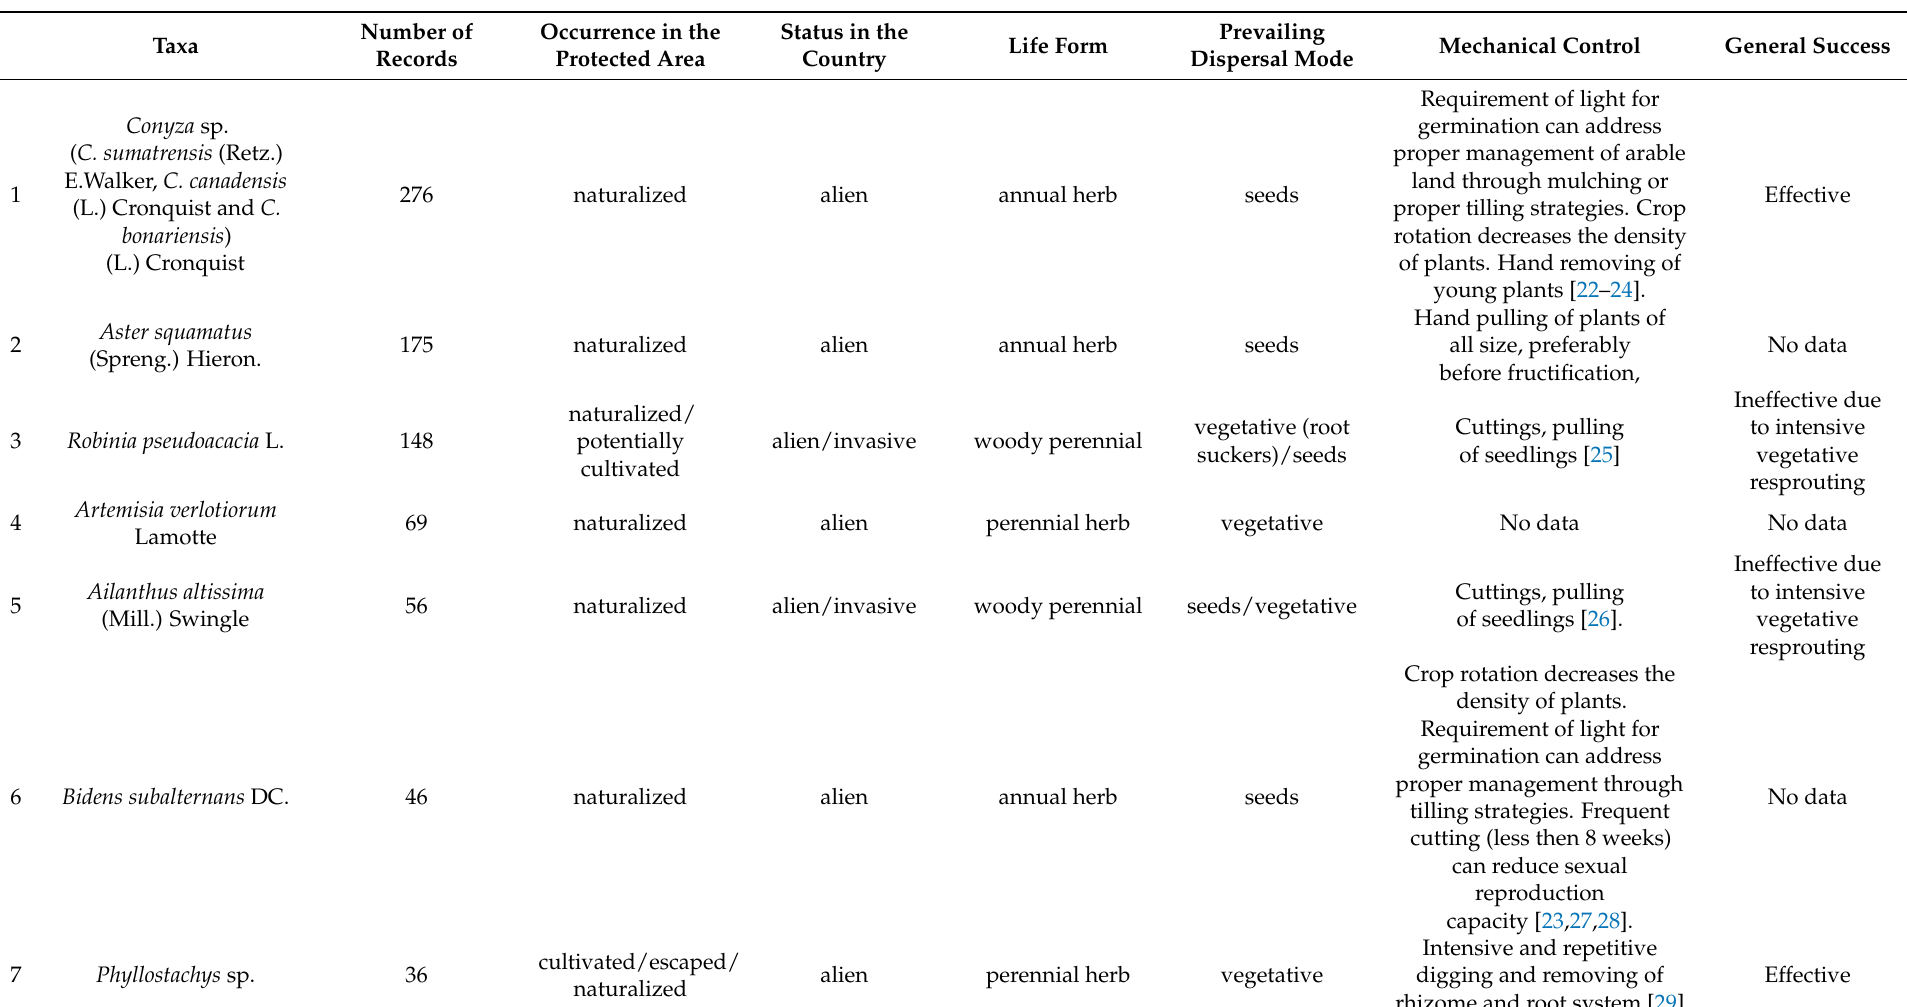
Table 2. Alien plant taxa included in the study and basic information about their biology and their management as reported in the